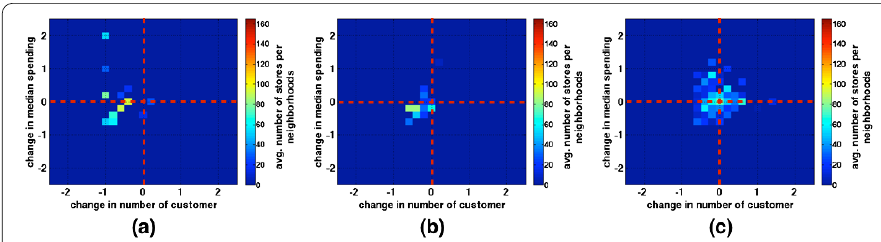
Figure A1 The 2-D histograms of the number of neighborhoods in terms of the two behavioral indexes for Day 77 in the data set: ( a ) within 2 km; ( b ) from 2 to 4 km; ( c ) above 4 km. The horizontal and vertical dashed lines indicate changes of a magnitude less than 0.1